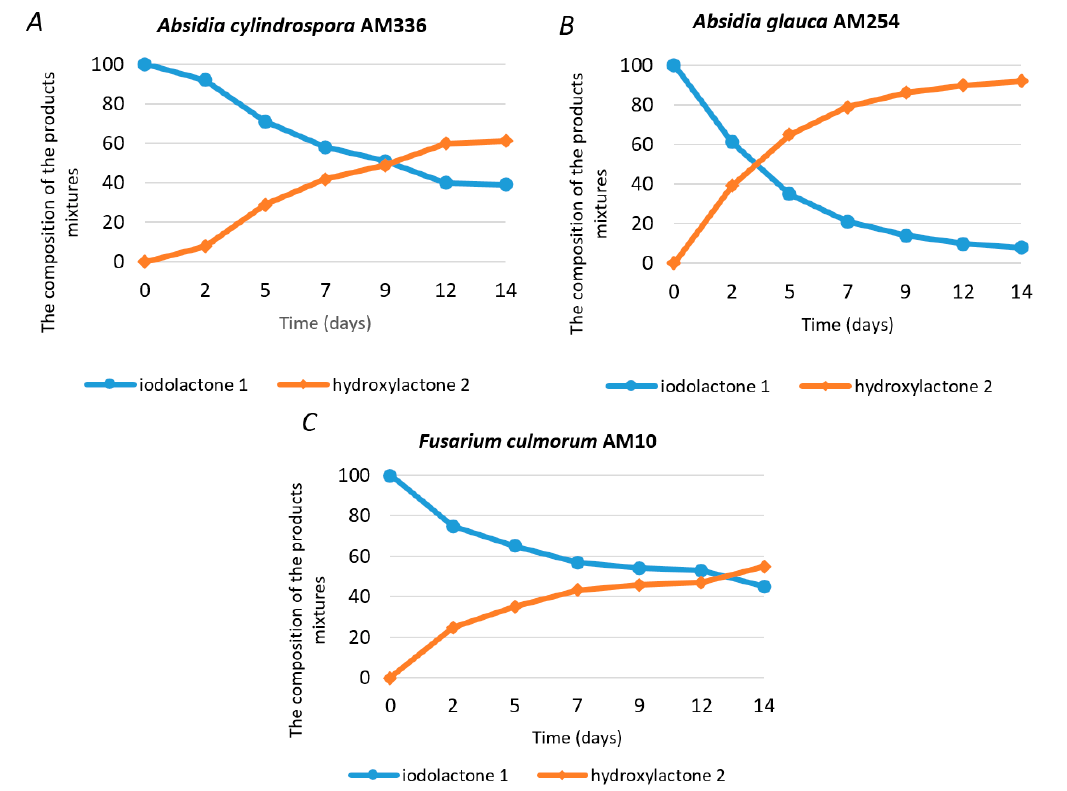
Figure 1. Composition (in % according to GC) of the product mixtures in the screening biotransformations of racemic iodolactone ( rac - 1 ) by different fungal strains. ( A ) Absidia cylindrospora biotransformations of racemic iodolactone ( rac - 1 ) by di ff erent fungal strains. ( A ) Absidia cylindrospora AM336; ( B ) Absidia glauca AM254 and ( C ) Fusarium culmorum AM10. AM336; ( B ) Absidia glauca AM254 and ( C ) Fusarium culmorum